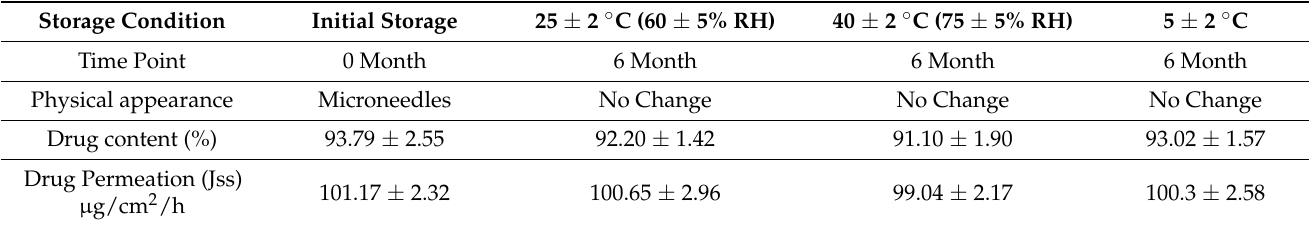
Table 4. The stability study of the prepared CUBs-MN D under all storage